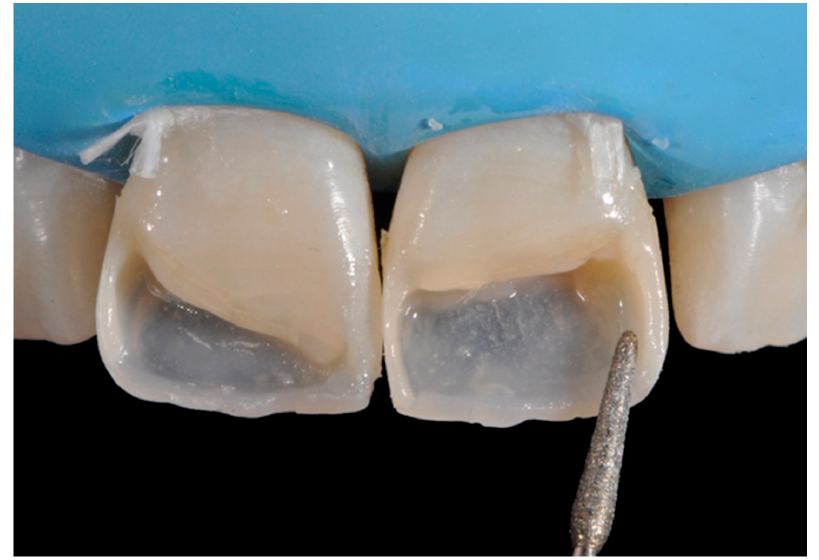
Figure 33. Frame imprecisions are corrected by reducing interproximal wall from the internal side. Reprinted from Restauri diretti nei settori anteriori, G. Paolone, S. Scolavino, © 2021, with permission from Quintessence Publishing Italy.